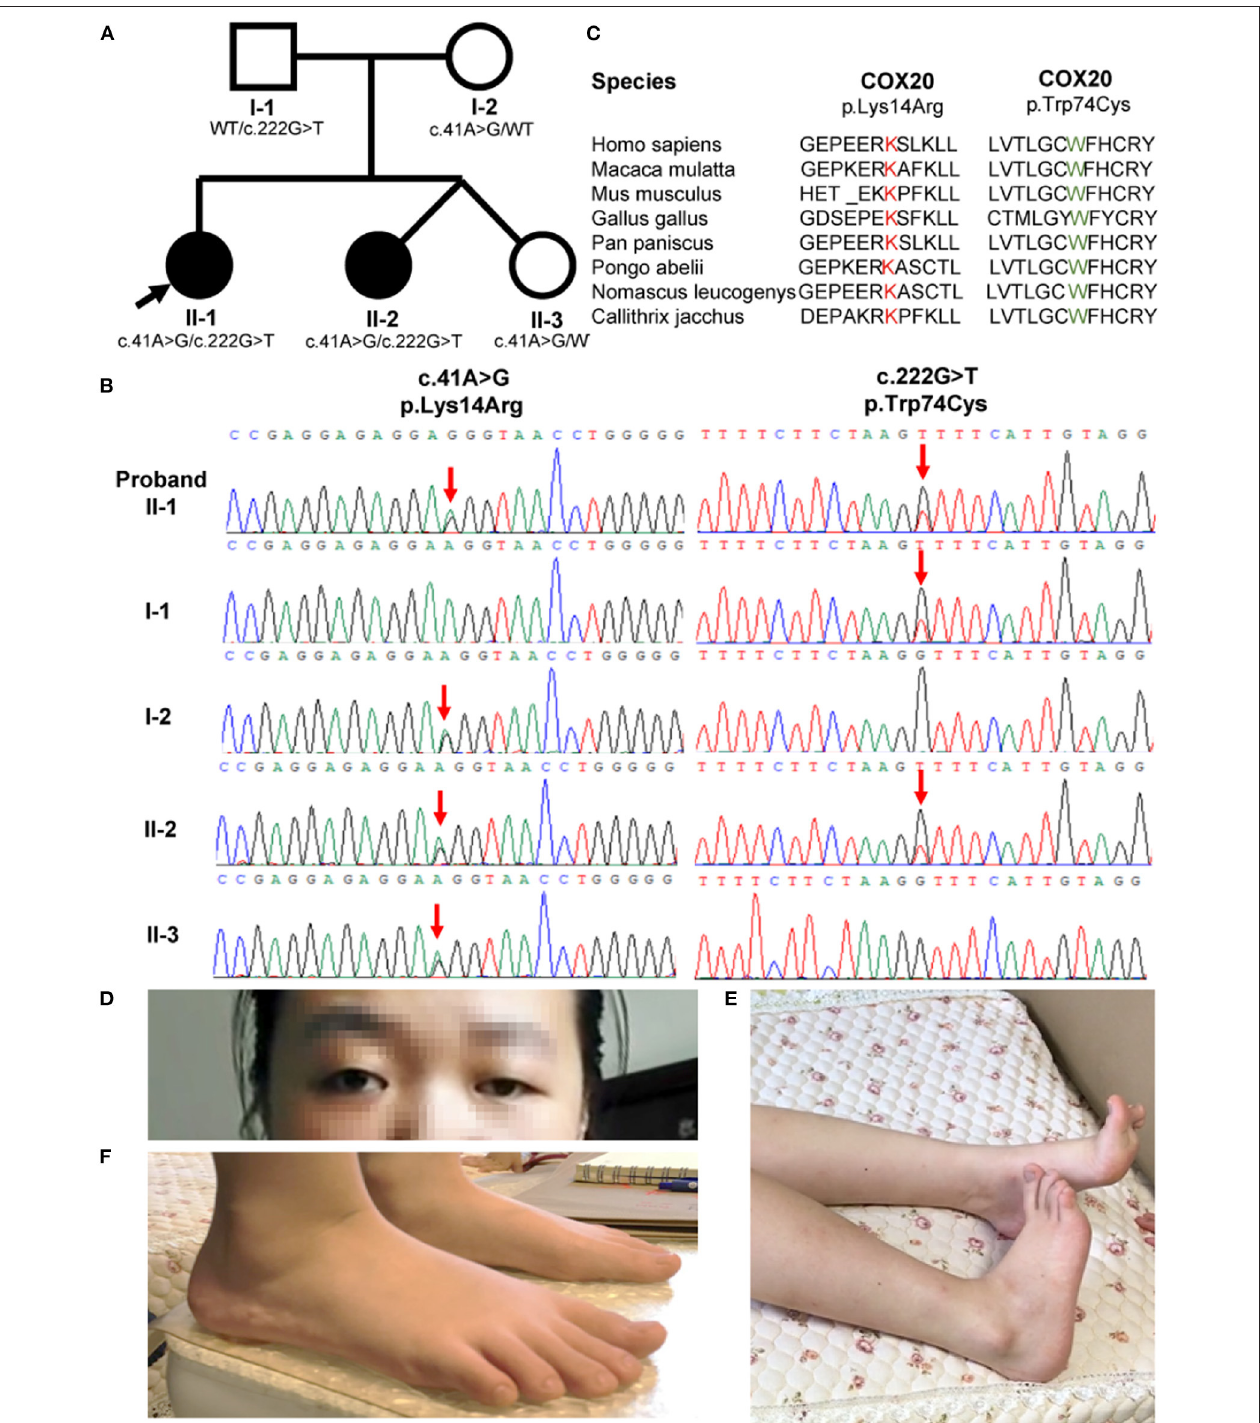
FIGURE 1 | Family pedigrees and COX20 variants. (A) Pedigree of the COX20 family. Affected siblings are indicated in a solid circle, while asymptomatic individuals are represented in open symbols. Their genotypes are described under the symbols. Proband is indicated with an arrow. (B) Chromatographs of the COX20 variants of all family members. Red downward arrows point to the position of each variant. (C) Protein homology across divergent species. Both affected amino acid residues were highly conserved across the species. (D) Strabismus and left-sided ptosis (pictures from the proband II-1). (E) Striatal toe (pictures from the proband II-1). (F) Flatfoot (pictures from the proband’s sister